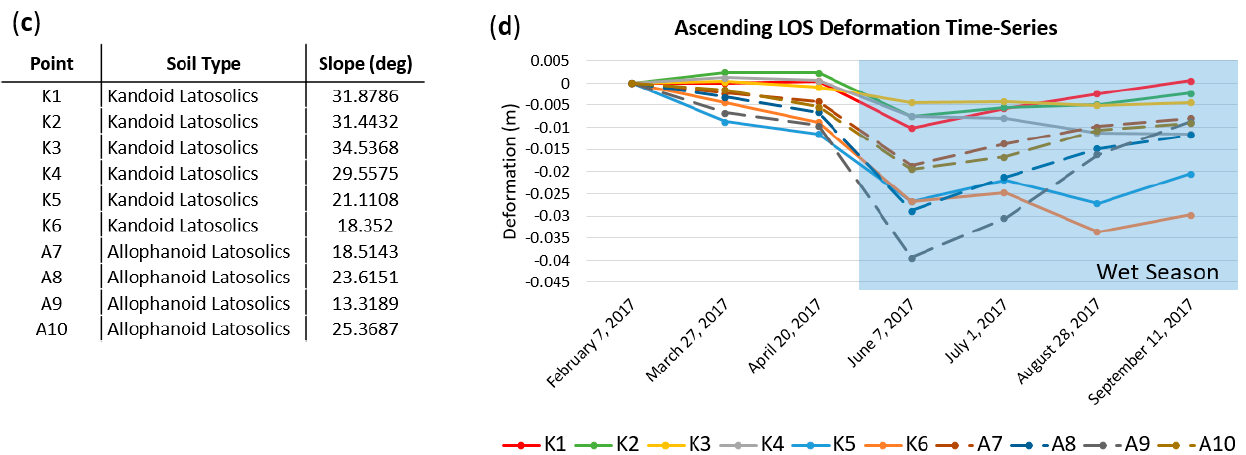
Figure 5. ( a ) Pre Hurricane Maria LOS ascending deformation-rate map overlaying the soil types. ( b ) Debris Flows (DF), Debris Slide (DS), and flood/debris flow channels (SS) triggered by Hurricane Maria overlaying the annual rainfall map. DS appears to be the most dominant landslide type over the DF and SS. InSAR shows more land motion prior to failure on the clay soil with gentler slopes than steeper slopes. ( c , d ) are the slope details and time-series of the 10 points highlighted in ( a , b ), respectively. Soil type and annual rainfall data provided by [42,56], respectively.